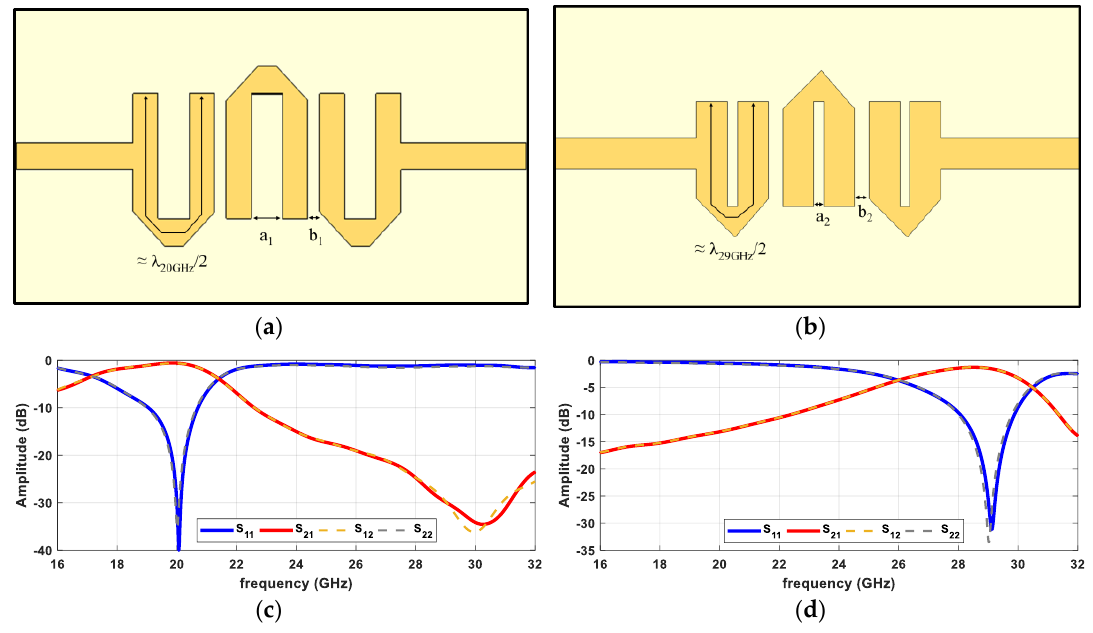
Figure 7. Structure of hairpin filters and its S-Parameters simulation: ( a ) filter in 20 GHz band; ( b ) filter in 29 GHz band; ( c ) 20 GHz hairpin filter response; and ( d ) 29 GHz hairpin filter